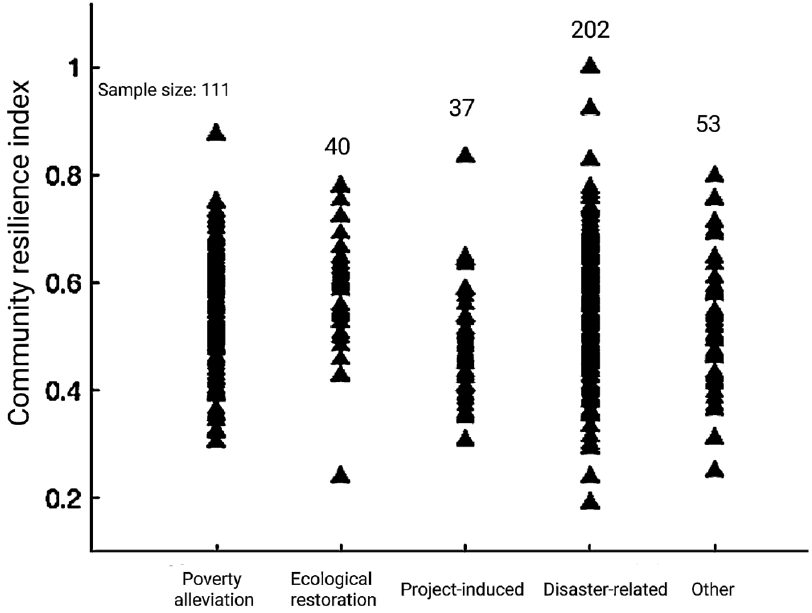
Figure 3. Community resilience index of relocated households by different relocation types.